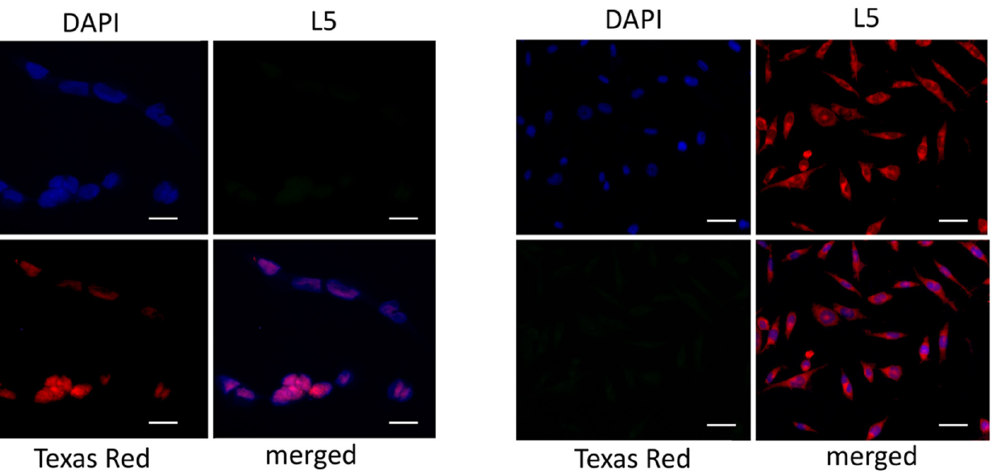
Figure 6. Fluorescence microscope images of hFOB 1.19 incubated with 4 ( left ) and with 4@MSN ( right ). Bar = 1 μ m. ( right ). Bar = 1 µ